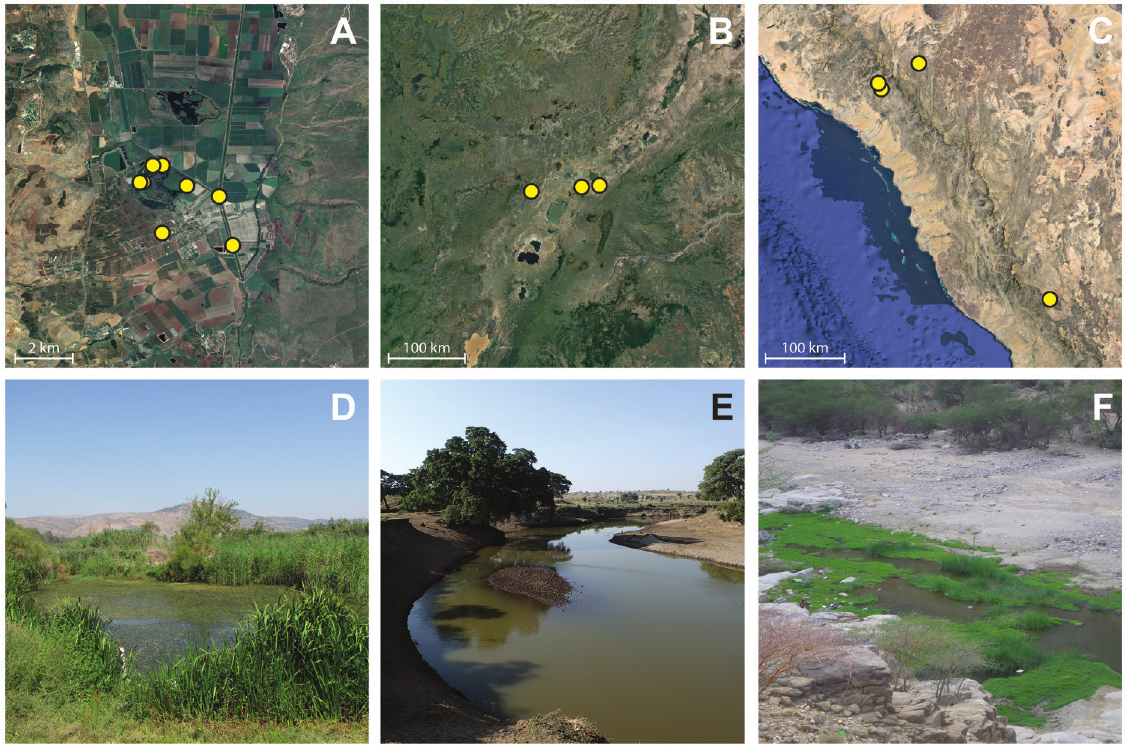
Fig. 3. Habitat general appearance in newly reported populations. A , D . Hula Nature Reserve, Israel. B , E . Awash River, Ethiopia. C , F . Wadi Elarj, Saudi Arabia. Photos by Google (A–C), Yanai Z. (D) , Graf W. (E) and Gattolliat J.-L.